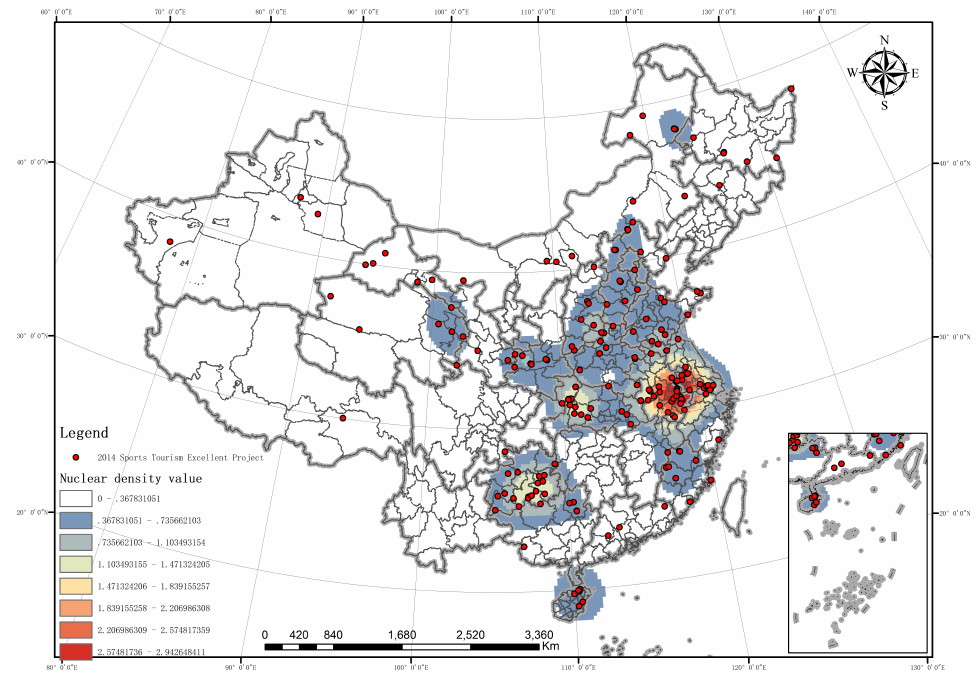
Figure 3. Distribution of core density of China’s sports tourism resources in 2014. The color in the figure changes from gray to red: the redder the color, the more clustered the sports tourism projects. See the nuclear density index as shown in the legend for